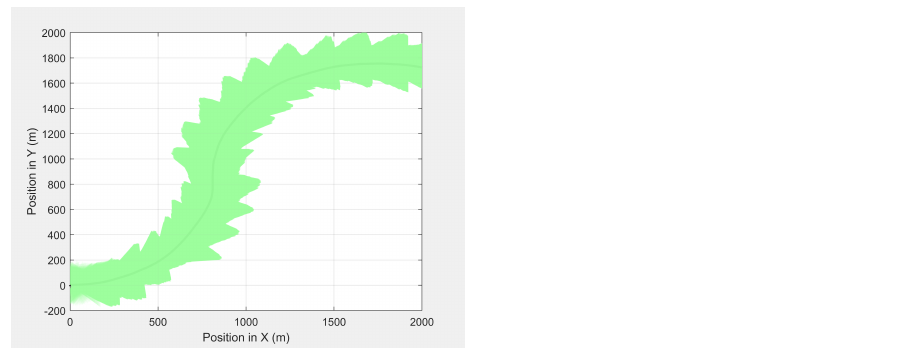
Figure 18. The camera’s footprint as the UAV follows the MGV while moving along an unstructured path.